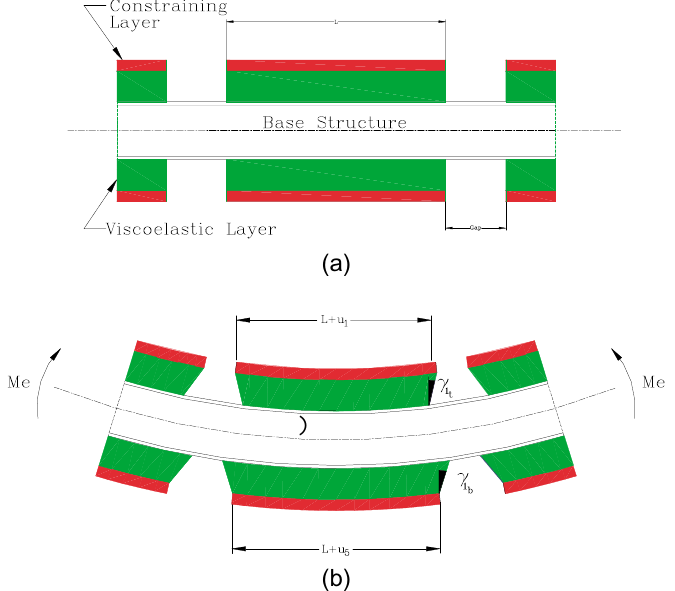
Fig. 1. Conventional multi-segment Passive Constrained Layer Damping (a) undeflected configuration and (b) deflected configuration.